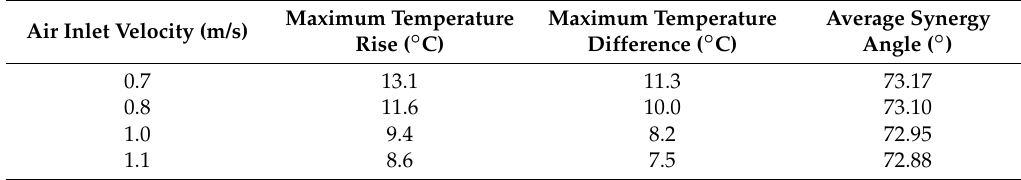
Table 1. Temperature rises and temperature differences for different air inlet velocities.